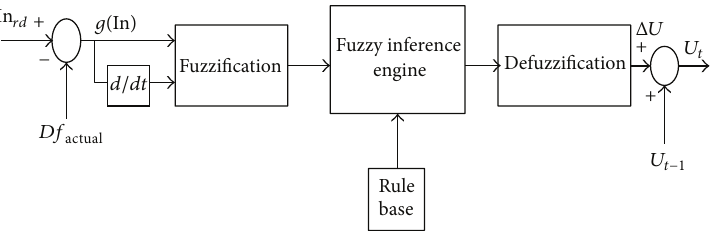
Figure 6: Block diagram of fuzzy